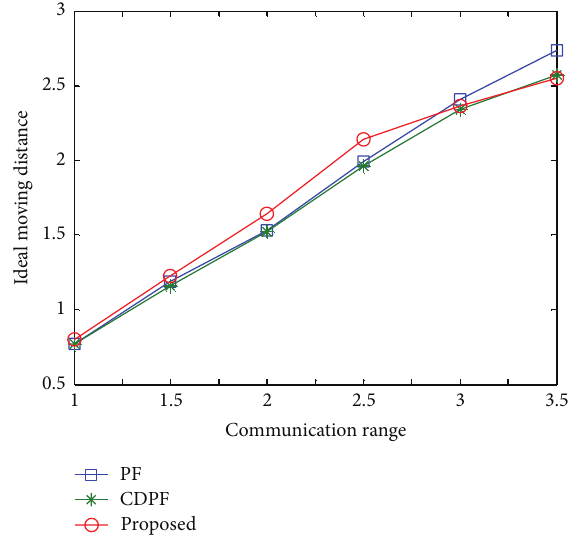
Figure 5: Ideal moving distance versus communication range /𝑟 ) (𝑟 𝑐 𝑠